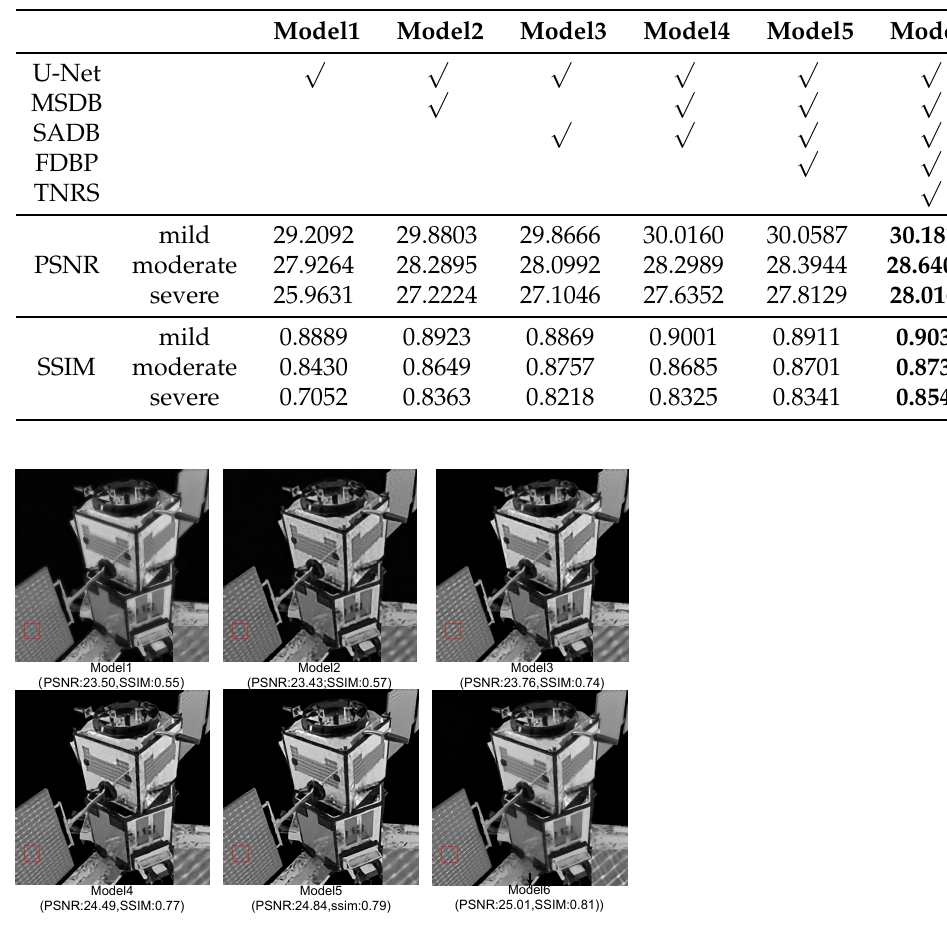
Table 2. Performance of models with different components (The best results are shown in bold fonts).